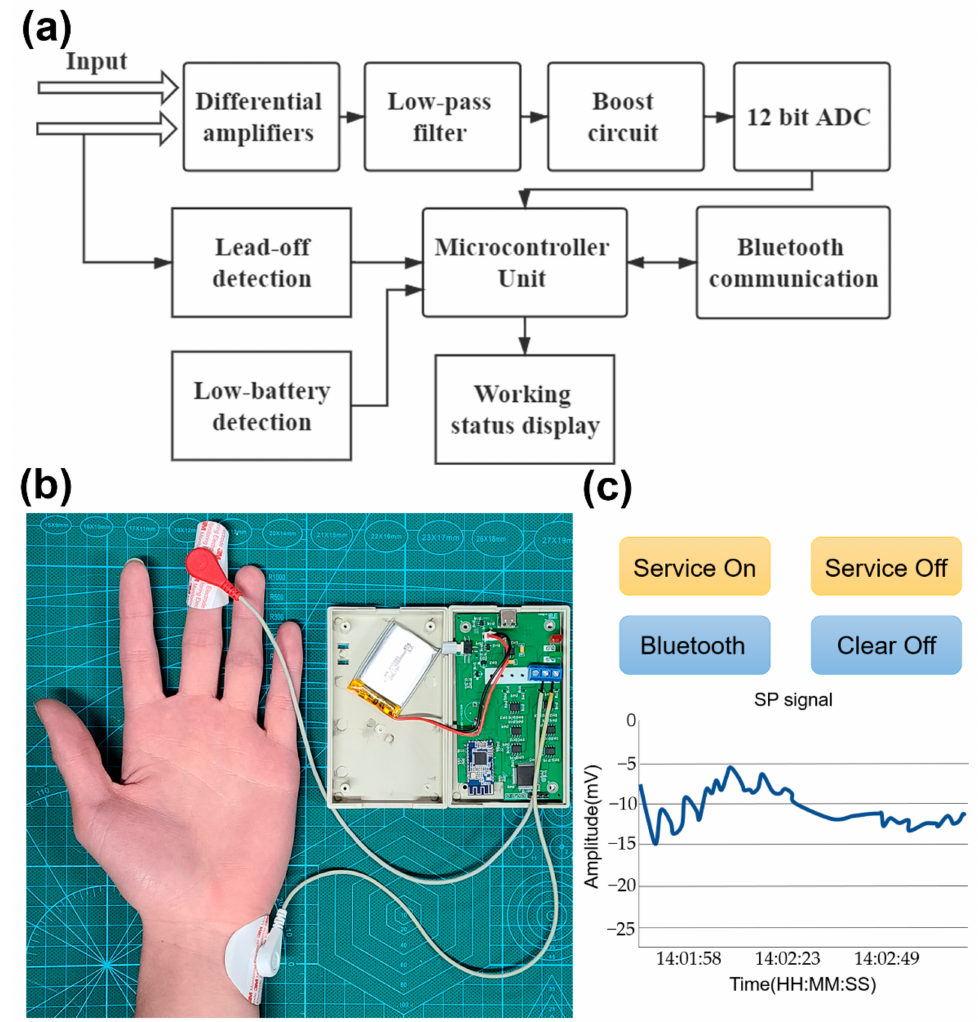
Figure 1. ( a ) Block diagram of the circuit functions of the portable device. ( b ) The portable device for skin potential (SP) signal acquisition. ( c ) The screenshot of the application when it receives